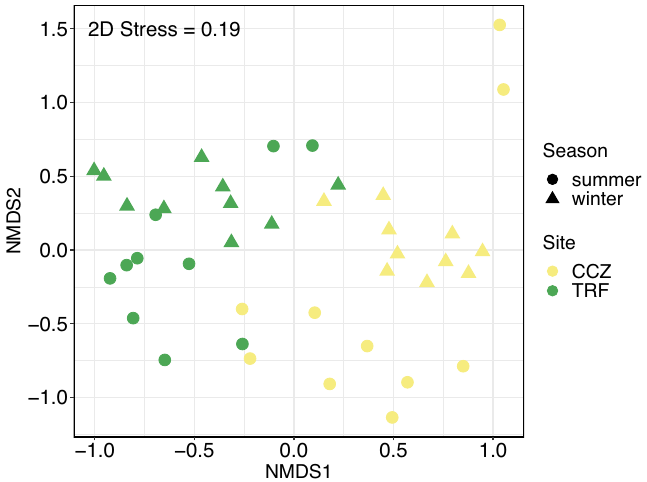
Figure 5. Non-metric multidimensional scaling (NMDS) plot showing the Bray–Curtis dissimilarity based on ZOTU relative abundance.